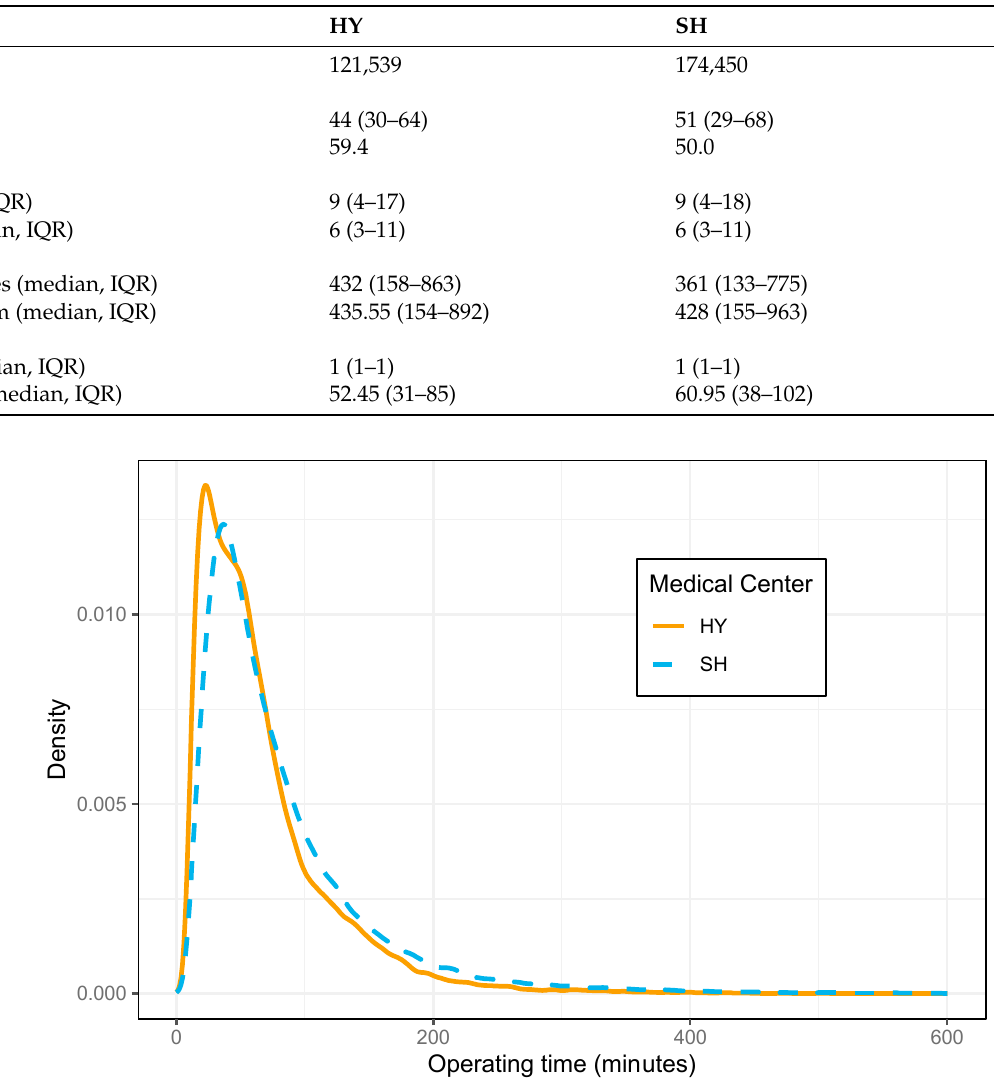
Table 2. Statistical summary of the data used in the study, stratified by hospital. N: Number of surgeries. IQR: Interquartile Range.